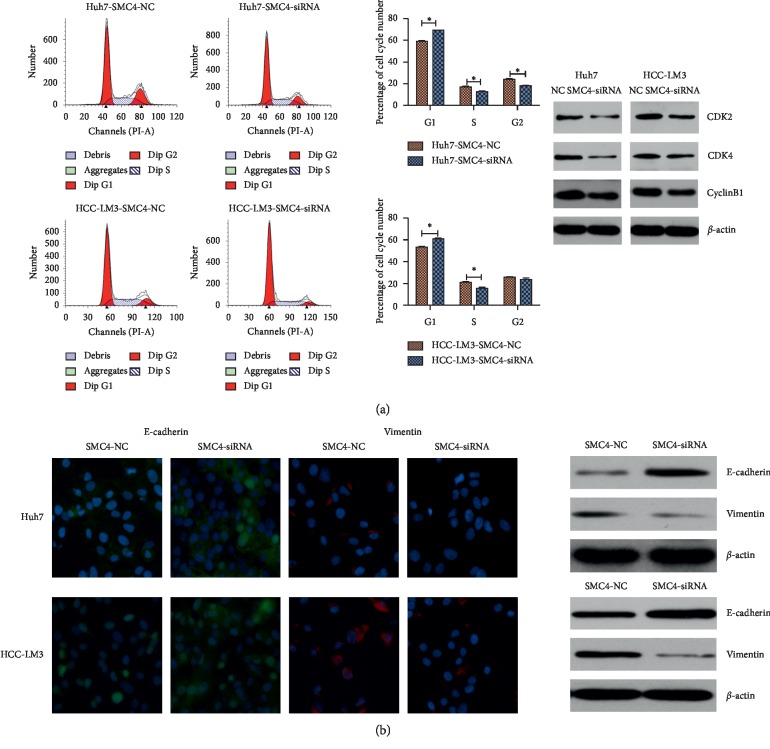
Suppression of SMC4 induces G1 phase arrest and inhibits process of EMT. (a) Flow cytometry was used to analyze the percentage of different cell cycle phases in HCC cells with SMC4 siRNA and negative control under hypoxic condition. The result of statistical analysis was shown by Histogram. And the expression changes of CDK2, CDK4, and CyclinB1 were detected by western blot, and β-actin was used for internal control. n = 3, ∗p < 0.05. (b) IF and western blot were used to detect expression changes of E-cadherin and Vimentin under hypoxia in HCC cells with SMC4 siRNA and negative control, and β-actin was used for internal control.